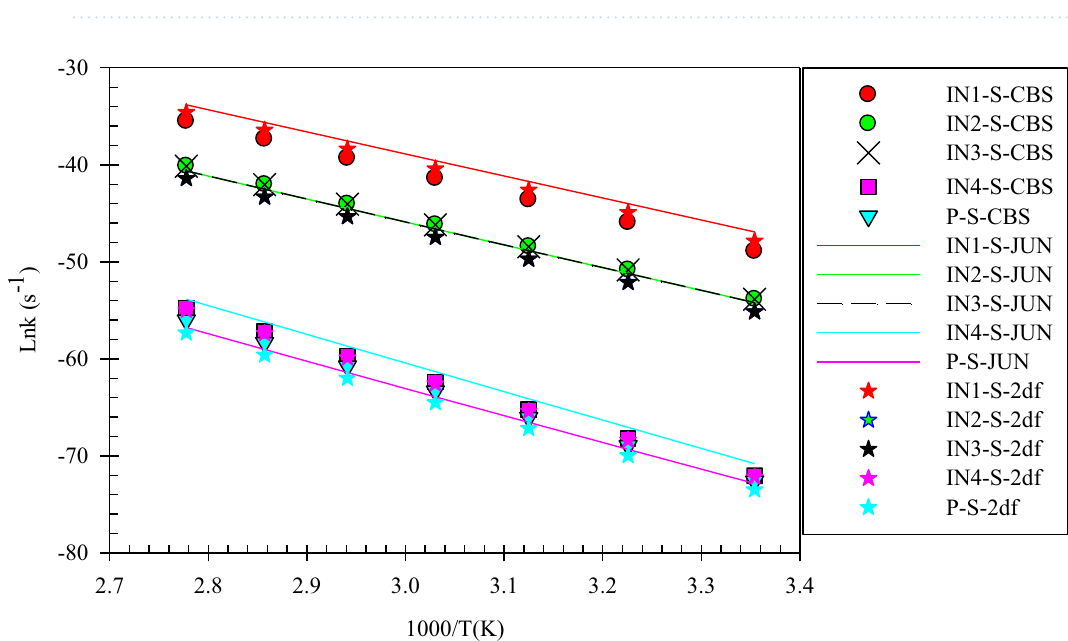
Figure 9. Overall rate constants for production of all minimum stationary points in 3-hydroxythiophen-2(5H)- one unimolecular reaction calculated at three different levels over 298.15–360 K temperature